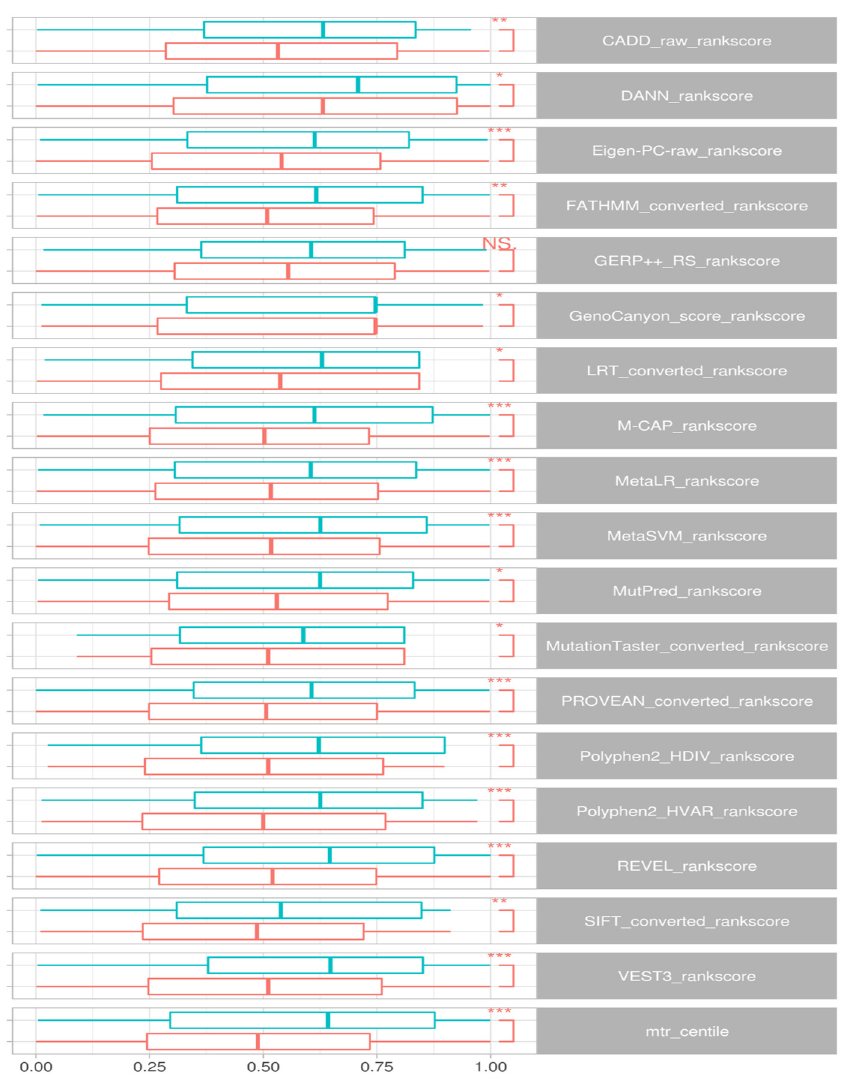
Figure 3. Comparison of in silico predictors of deleteriousness. Boxplots display rank score distribu- tions for de novo missense variants across all genes, comparing case-ascertained variants (salmon) with combined variants from control groups 1 and 2 (blue). Significance was denoted by Wilcox signed rank tests, with NS not significant; * p < 0.05; ** p < 0.01; *** p < 0.001.